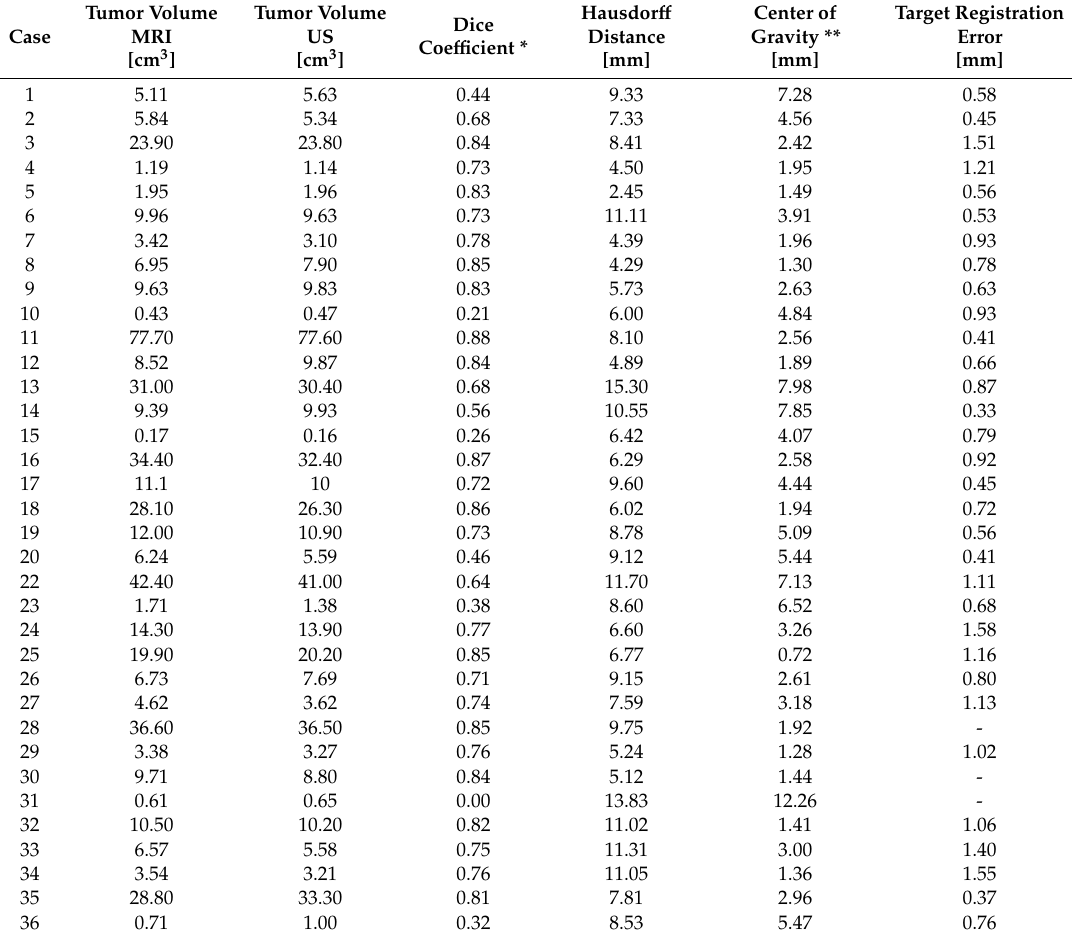
Table 2. Tumor object characteristics and the target registration error (TRE).